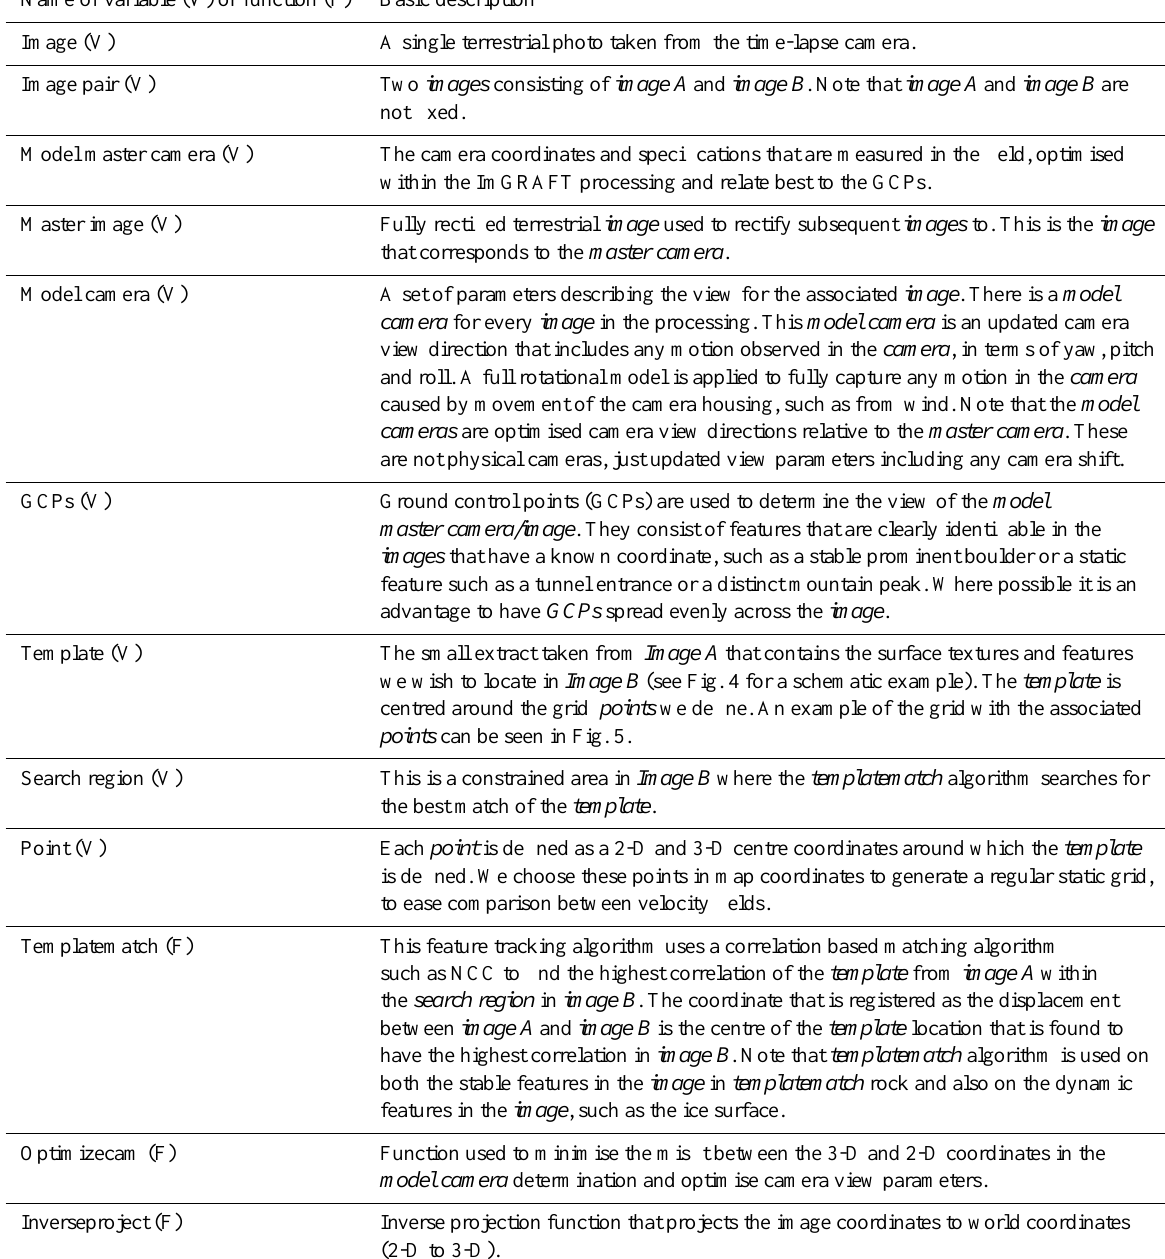
Table 1. Description of key terminology used in the code, flow diagram in Fig. 3 and frequently referred to in the main body of the text. The first column presents the variable or function name, the second column indicates if it is a variable or a function and the third column provides a short description of the associated